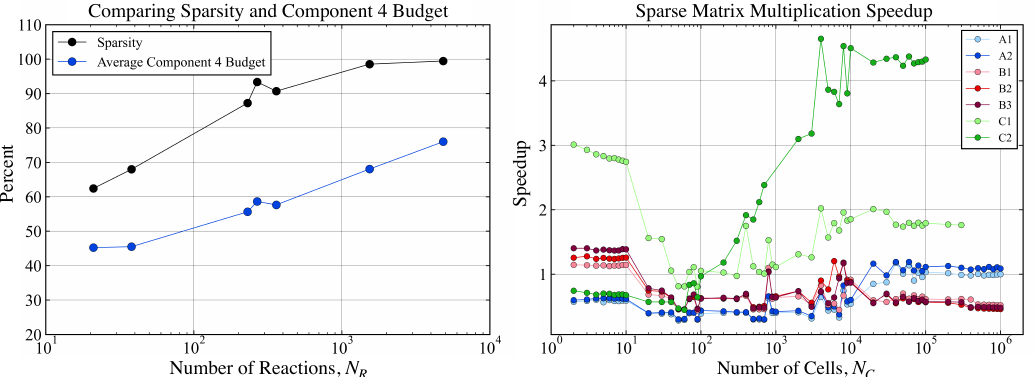
Figure 10. ( Left ) Mechanism sparsity and average component 4 budget (the budget corresponding to the evaluation of Equations (2) and (4)) versus number of reactions N R . ( Right ) Dense (cuBLAS) to sparse (cuSPARSE) matrix multiplication speedup (dense compute times divided by sparse compute times) for evaluating Equation (2) shown for all mechanisms with respect to N C . See Table 1 for mechanism information.